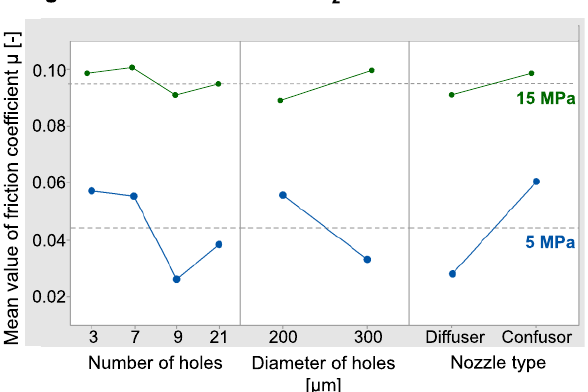
Fig. 13. Main effects on coef fi cient of friction m determined with strip drawing investigations at 5 MPa (lower, blue values) and 15 MPa (higher, green values) surface pressure, drawing speed 100 mm/s, lubrication medium N 2 . All values represent averaged values for the respective con fi gurations [12].